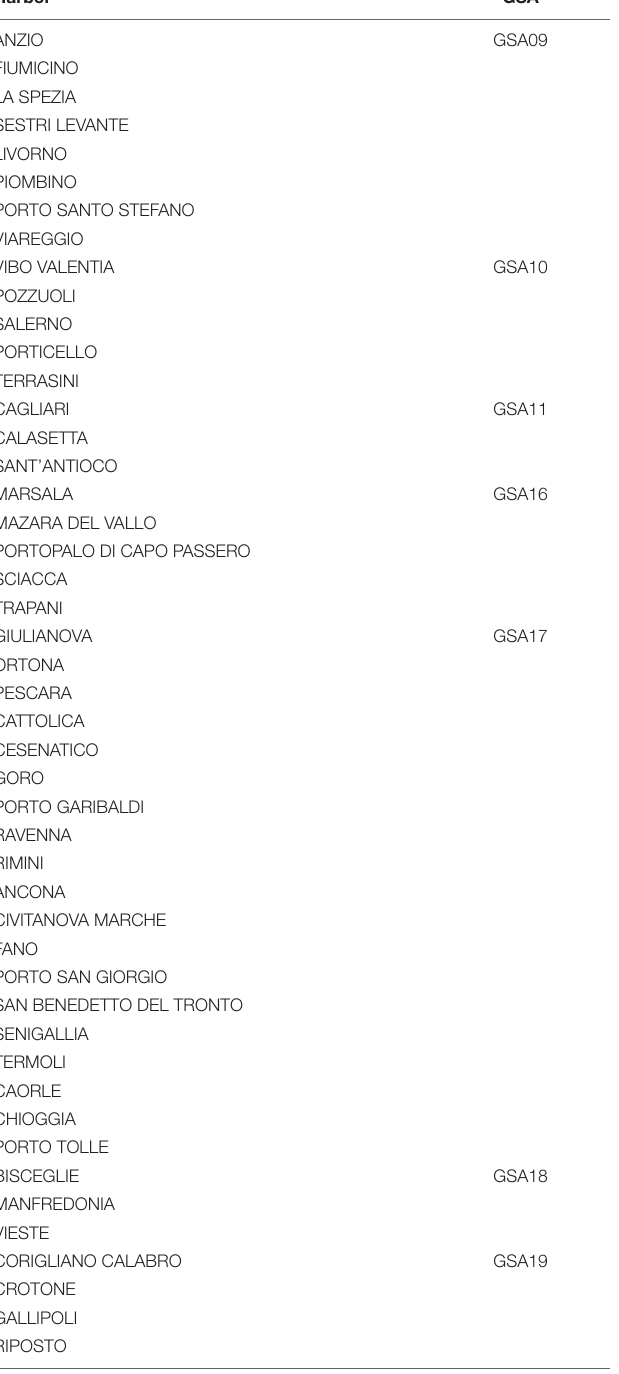
TABLE 1 | Harbors and corresponding GSA for which the total monthly landings of demersal species in the years 2019–2020 were compared. Harbor